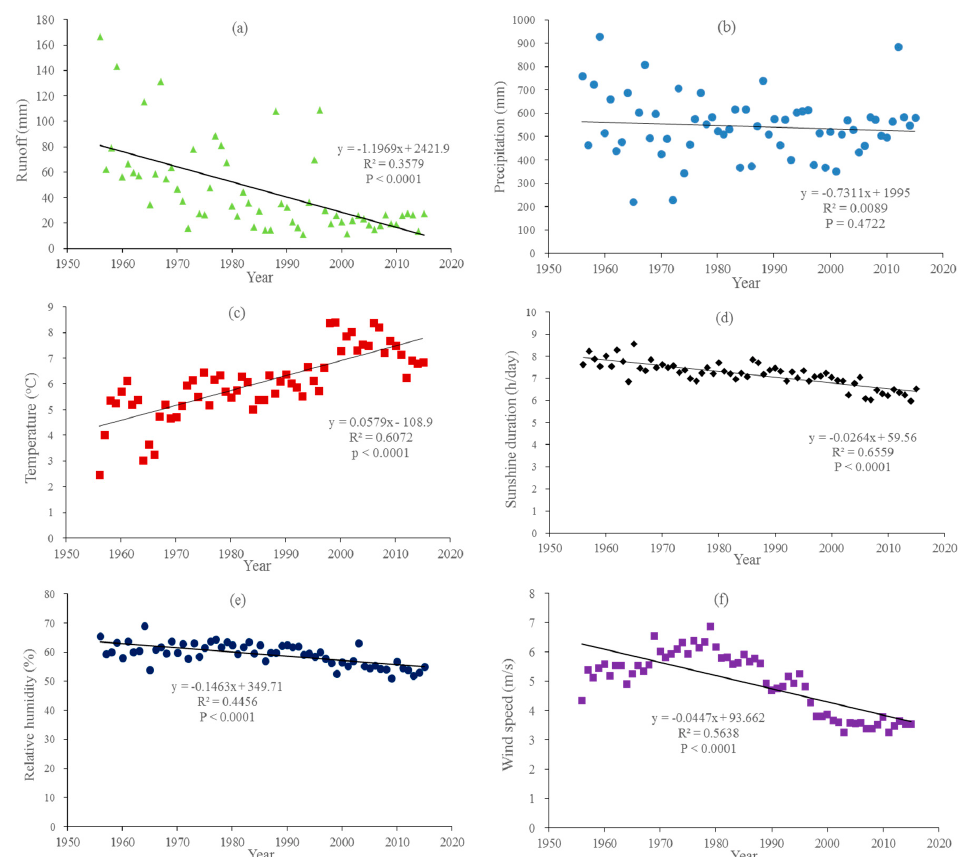
Figure 2. Long-term variations in R ( a ), P ( b ), T ( c ), SD ( d ), RH ( e ), and WS ( f ) series in the HTRB between 1956 and 2015 ( R 2 denotes the correlation coefficients for the relationships, and P denotes the statistical significance).